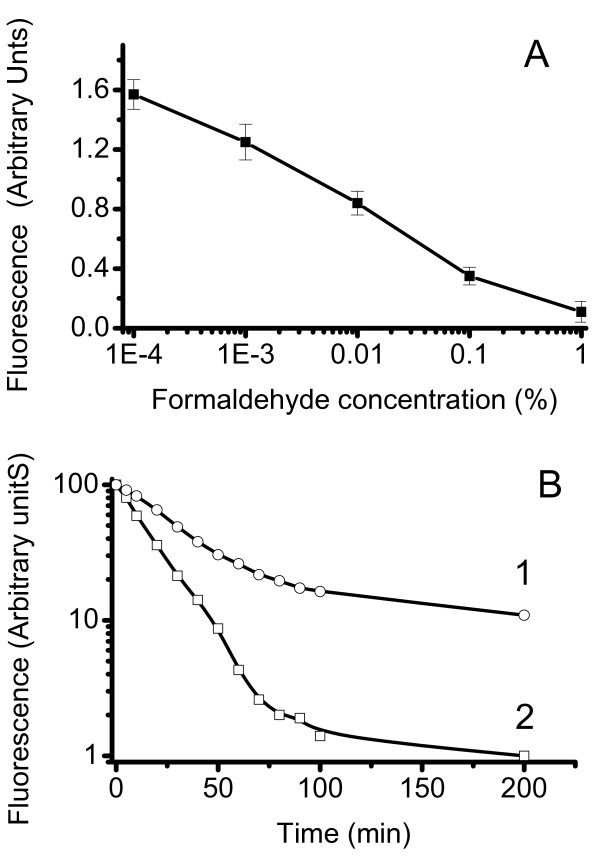
Reaction of formaldehyde with amino groups of neuronal tau. (A) Neuronal tau (final concentration 0.1 μM) was resuspended in phosphate buffer containing OPT (20 times molar excess compared to protein) in the presence of formaldehyde at different concentrations at 37°C for 120 min. The fluorescence (Ex340 nm/Em455 nm) was then measured. (B) Under the same conditions, tau was incubated with (curve 1) or without (curve 2) 0.005% formaldehyde and 2 μM OPT. Aliquots were then taken to measure the fluorescence at different time intervals. The data were plotted on a semilogarithmic scale as described by Tsou et al. [59].